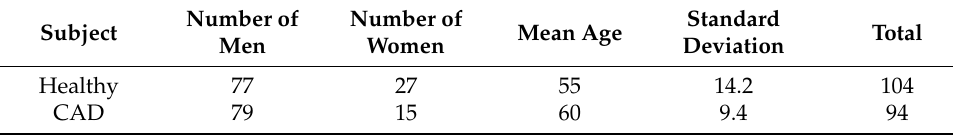
Table 1. Age and gender information of